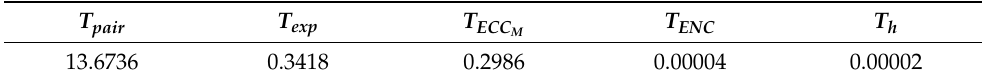
Table 5. Time cost (in ms) for the operations.